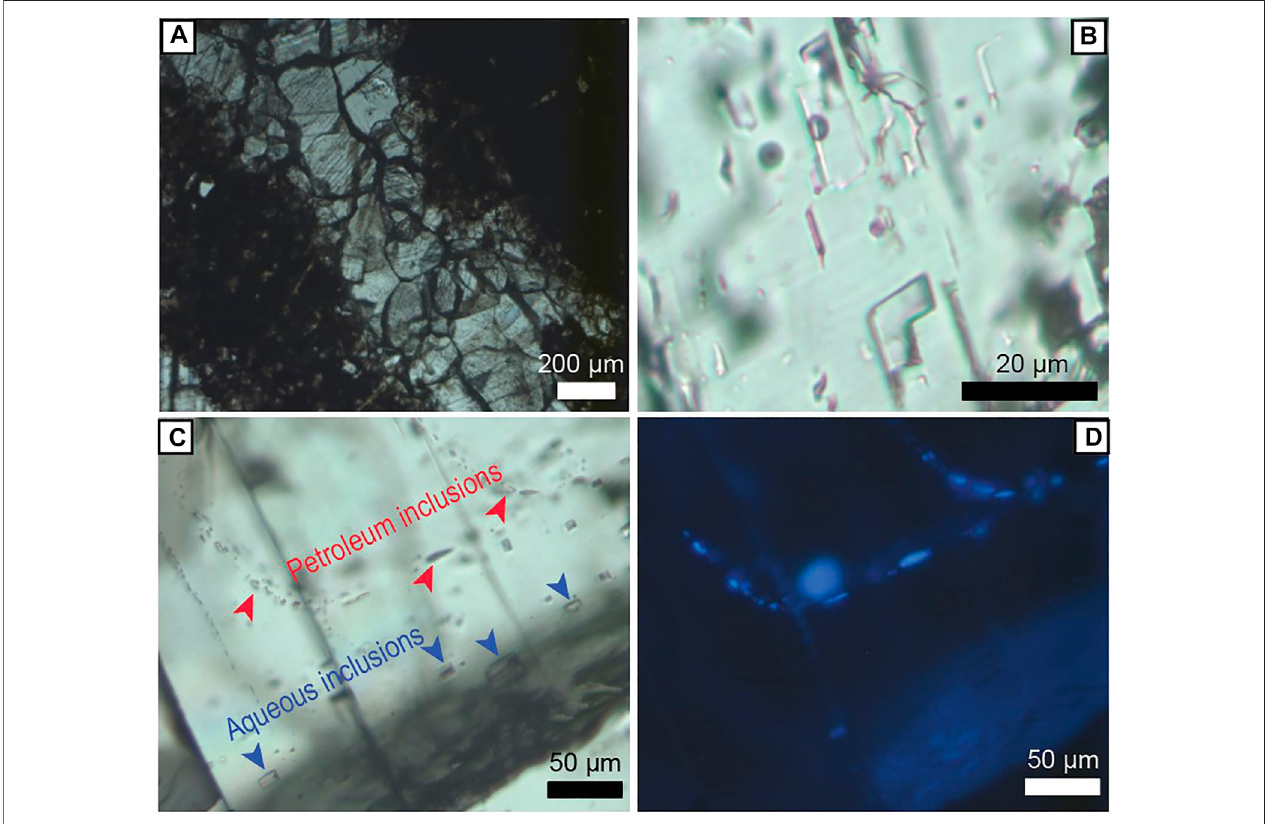
FIGURE 4| Fluid inclusion photomicrographs. (A) Blocky calcite texture typical ofcalcite veins used in this study. (B) Aqueous fl uid inclusionswithnegativecrystal shape(2,165 m). (C) Primaryaqueous fl uidinclusionsandsecondarypetroleuminclusionassemblage(1949m). (D) Sameas (C) butUVilluminationshowing fl uorescing petroleum and non- fl uorescing aqueous